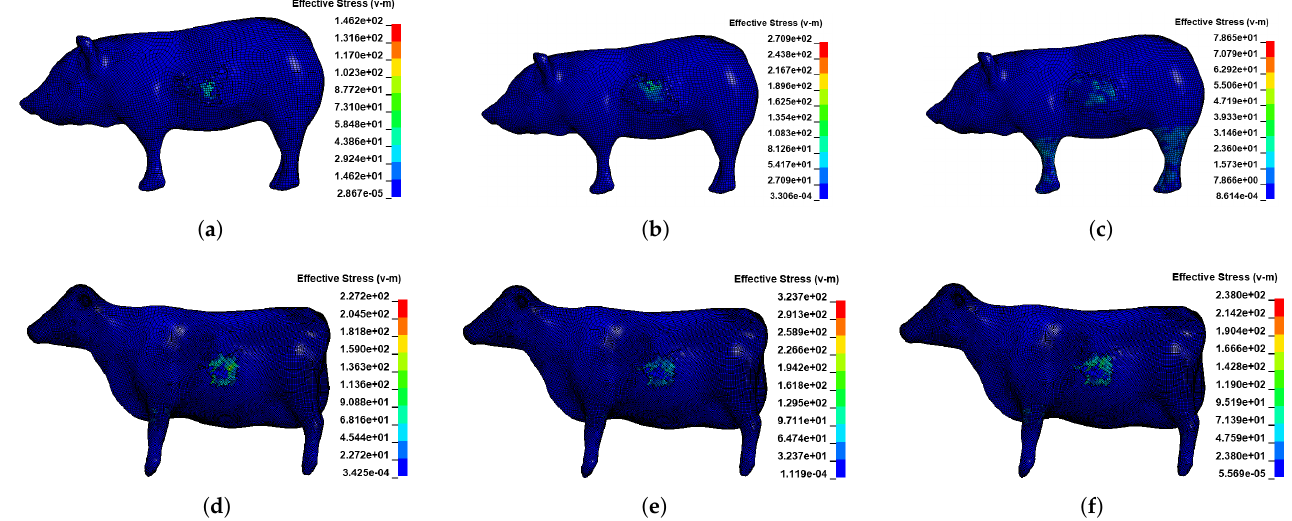
Figure 13. Stress clouds of the living body at each moment of the collision simulation: ( a ) Stress cloud at the moment before the maximum stress in the pig model; ( b ) stress cloud at maximum stress in the pig model; ( c ) stress cloud at the moment after the maximum stress in the pig model; ( d ) stress cloud at the moment before the maximum stress in the cow model; ( e ) stress cloud at maximum stress in the cow model; ( f ) stress cloud at the moment after the maximum stress in the cow model.